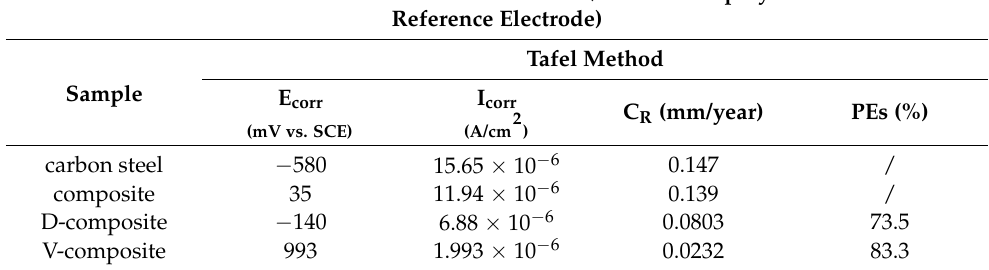
Table 1. Fitted corrosion characterizations for the coating samples after immersion in a 3.5% NaCl solution for 2 days by electrochemical corrosion measurements via the Tafel